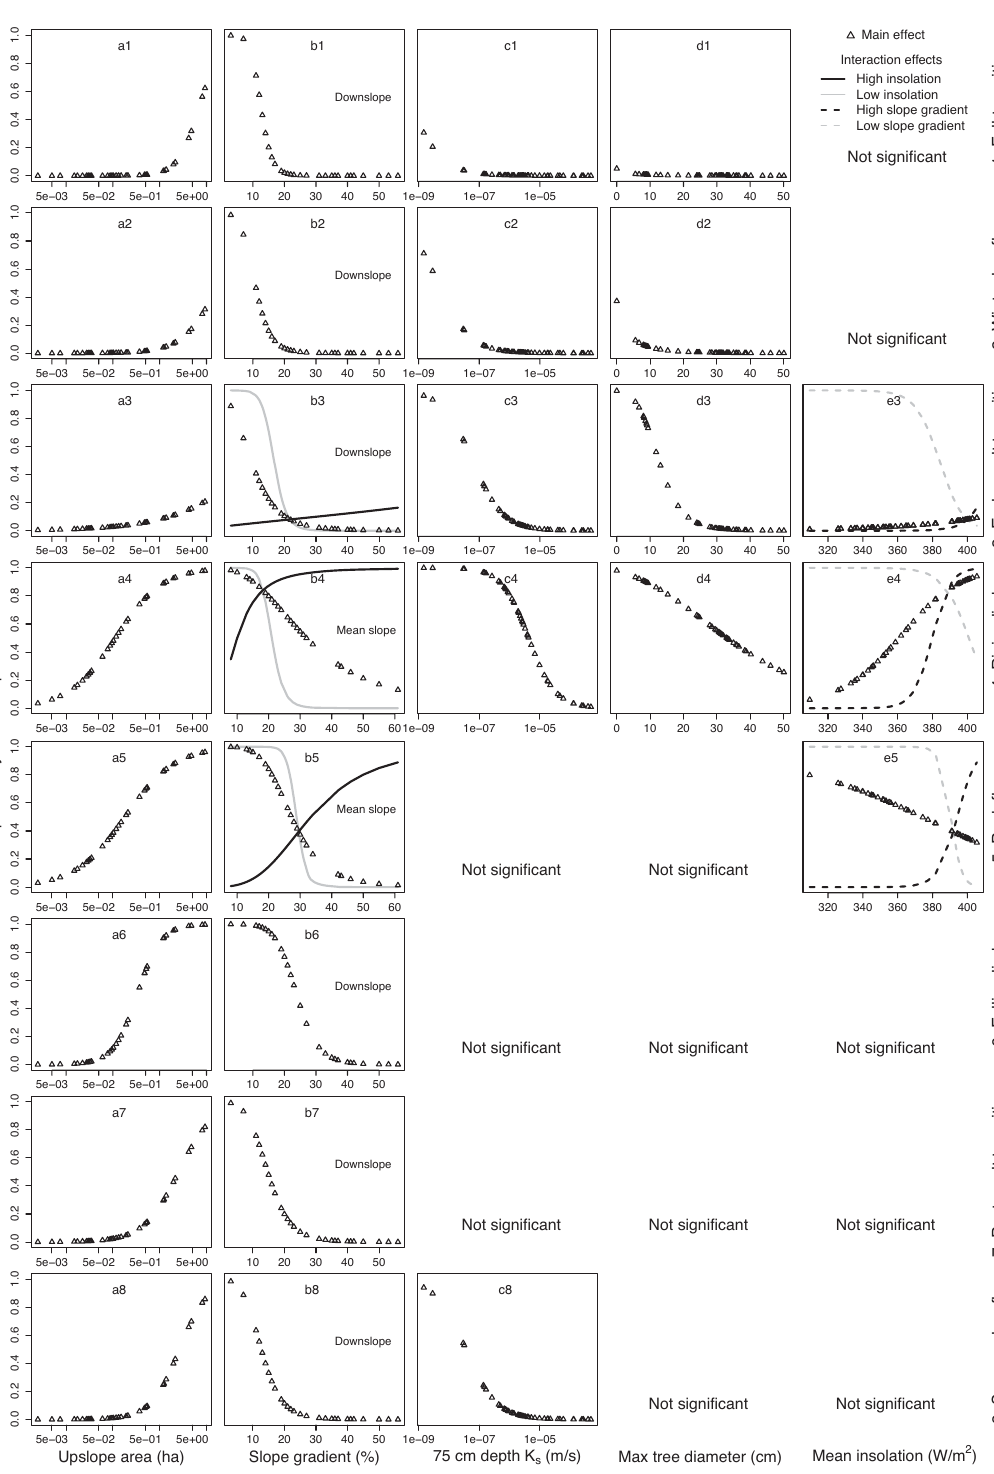
Figure 6. Partial probability of groundwater response for predictor variables in the logistic regression models. For slope gradient, mean of upslope and downslope gradients versus downslope gradient only is indicated in the panels. Streamflow periods are indicated on the far right side of the rows. Response variables for all rows are the duration of groundwater response. For calculating partial probabilities, all other predictor variables were held at their respective mean (geometric mean for K s ) values, except interaction variables, which were held at their respective minimum or maximum values. The timing of each period is indicated Sect. 2.3.3 and Fig.